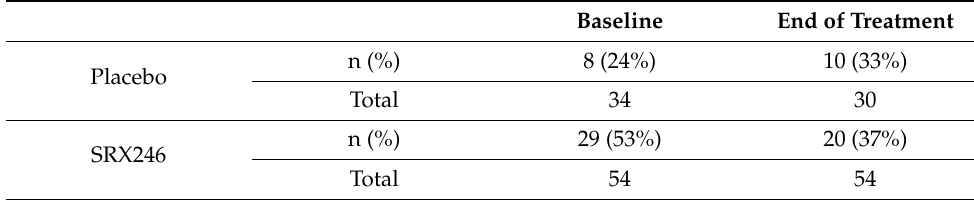
Table 5. ePRO estimate of the number of patients who “hit” at any time based on either patient or study partner reported